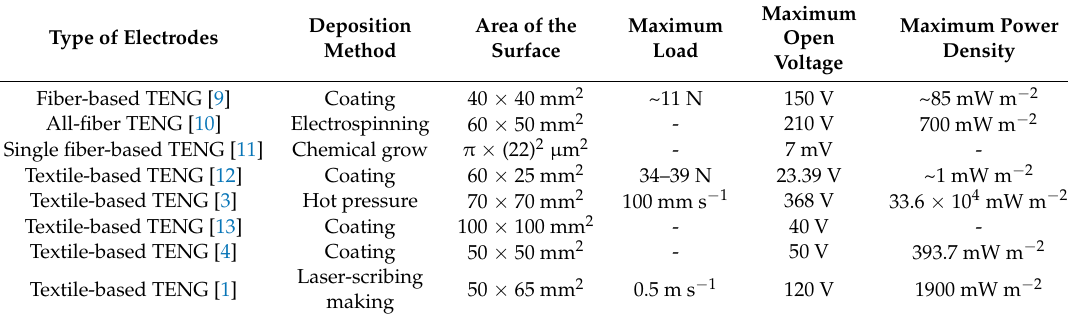
Table 1. Summary of fiber/textile-based triboelectric